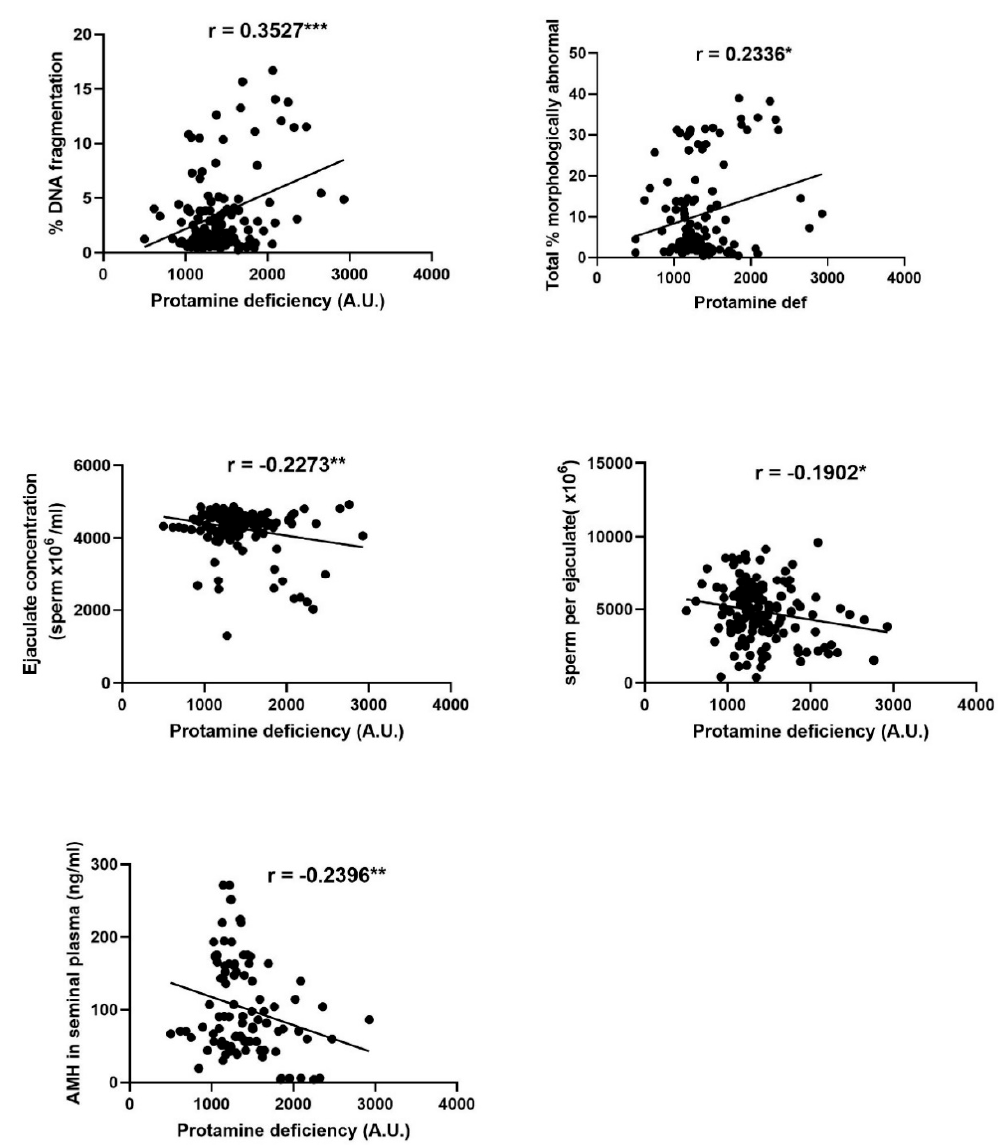
Figure 2. Significant correlations between sperm protamine deficiency and sperm DNA fragmentation, sperm concentration per ejaculate, the number of spermatozoa per ejaculate, anti-Mullerian hormone (AMH) in seminal plasma and the percentage of abnormal spermatozoa. Each data point plotted represents an individual ejaculate. Asterisks indicate the significance of the correlation * p ≤ 0.05, ** p ≤ 0.01, *** p ≤ 0.001.